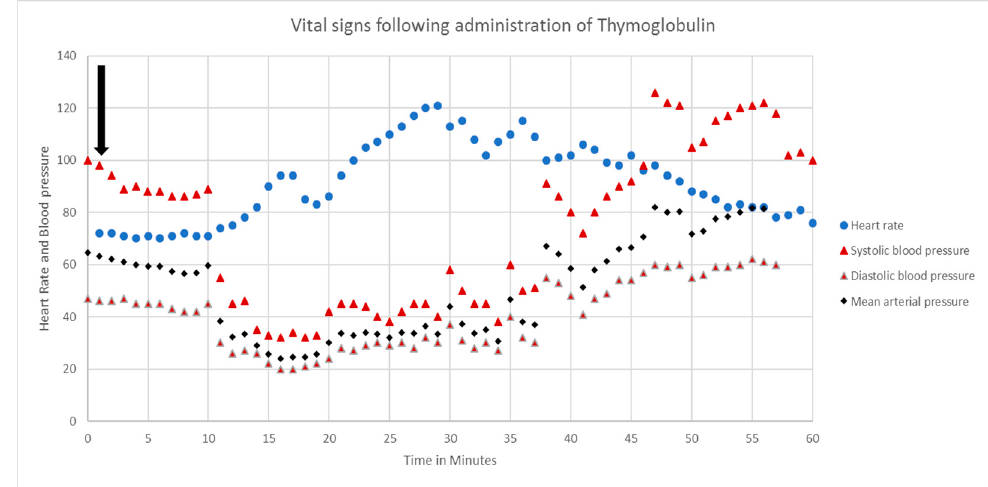
Figure 1. Intraoperative vital signs after administration of thymoglobulin.